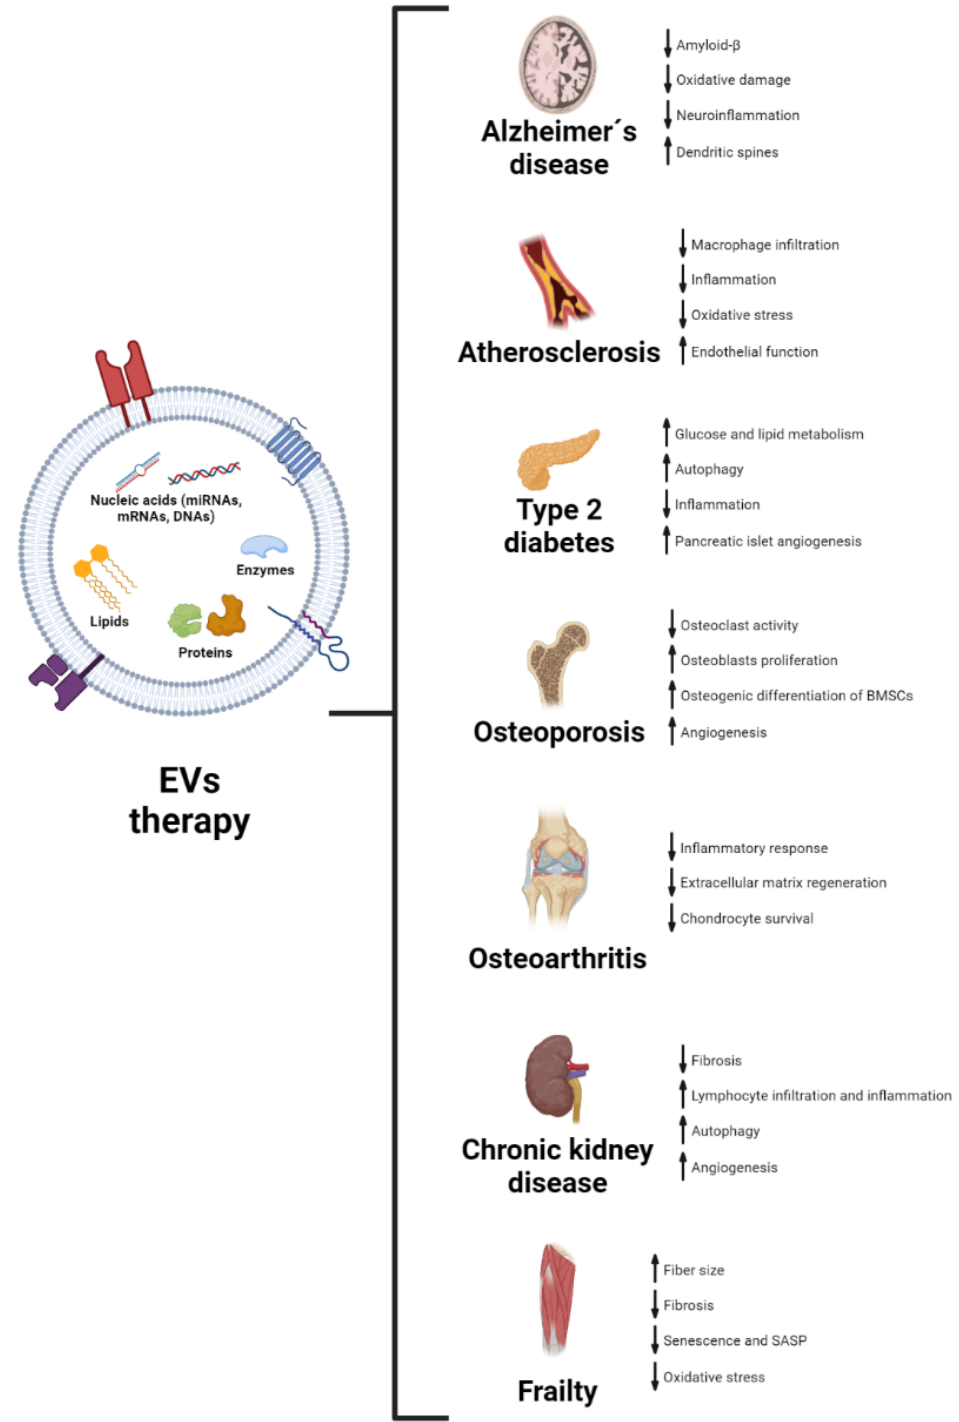
Figure 2. Recapitulation of the effects of treatment with EVs in preclinical models of age-associated diseases. For each condition, observed effects of EVs on different biological processes are shown, with an arrow indicating the increase or decrease in a concrete process. BMSCs: bone marrow-derived stem cells; SASP: senescence-associated secretory phenotype.